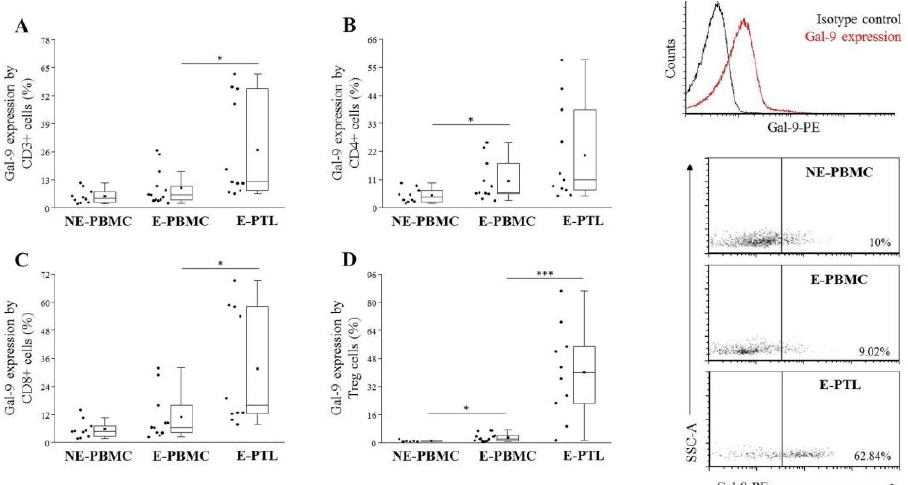
Figure 5. Comparison of the surface Gal-9 ligand expression by peripheral (PBMC) and peritoneal (PTL) CD3 + T ( A ), CD4 + T ( B ), CD8 + T ( C ) and Treg ( D ) cell subpopulations in non-endometriotic (NE) women and patients with endometriosis (E). Left: the solid bars represent medians of 10, 12, and 11 determinations; the boxes show the interquartile ranges, and the whiskers show the most extreme observations. The middle square within the box shows the mean value. Statistically significant di ff erences for p -values of *** < 0.01 and * < 0.05 are indicated. Right: representative histograms and dot plots showing Gal-9 ligand expression by T cells in NE-PBMC, E-PBMC and E-PTL